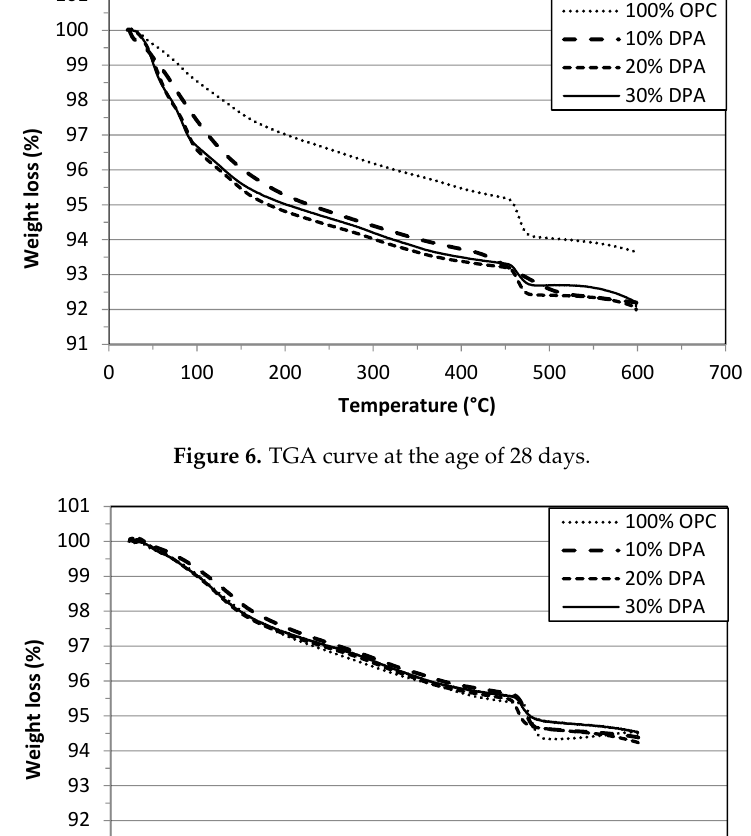
Table 2. Weight loss in paste mixtures at the age of 28 days.